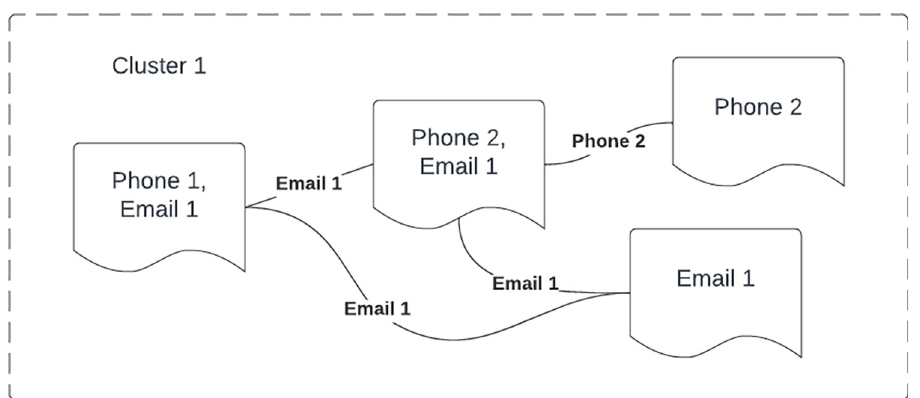
Fig 3. Example cluster created by DBSCAN. Ads are linked by common contacts. The virtual contact Cluster1 is associated with the ads containing contacts Phone1 , Phone2 and Email1 . The primary contacts Phone1 , Phone2 and Email1 are considered “neighbors” because each contact appeared in at least one ad with another contact in the cluster.